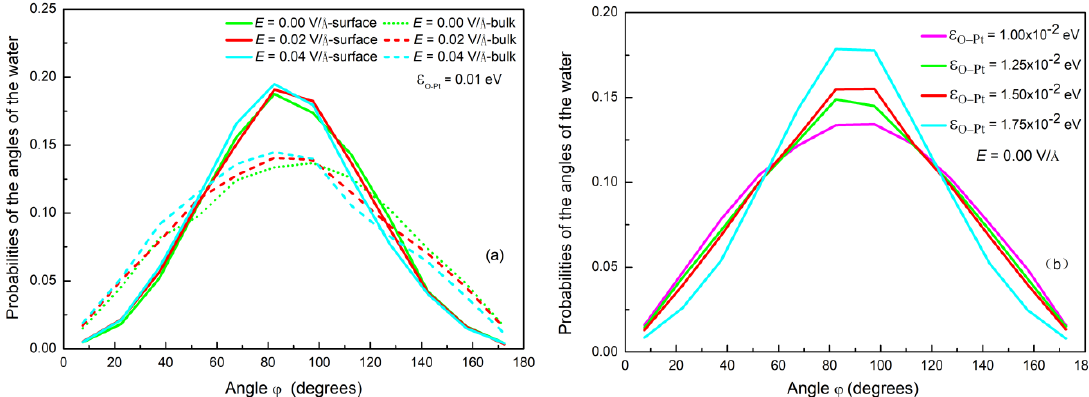
Figure 7. ( a ) The probability distribution of ϕ near the surface and in the bulk; ( b ) the probability of ϕ on different wettability surface with no electric field.